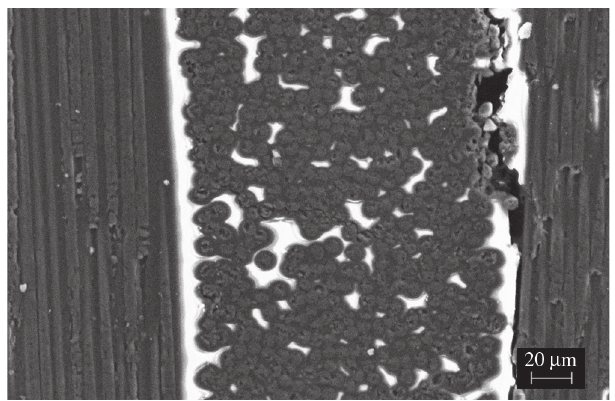
Figure 6. Fractograph of fiber/matrix interface of wet of carbon/epoxy fabric laminate (2.6% of moisture).